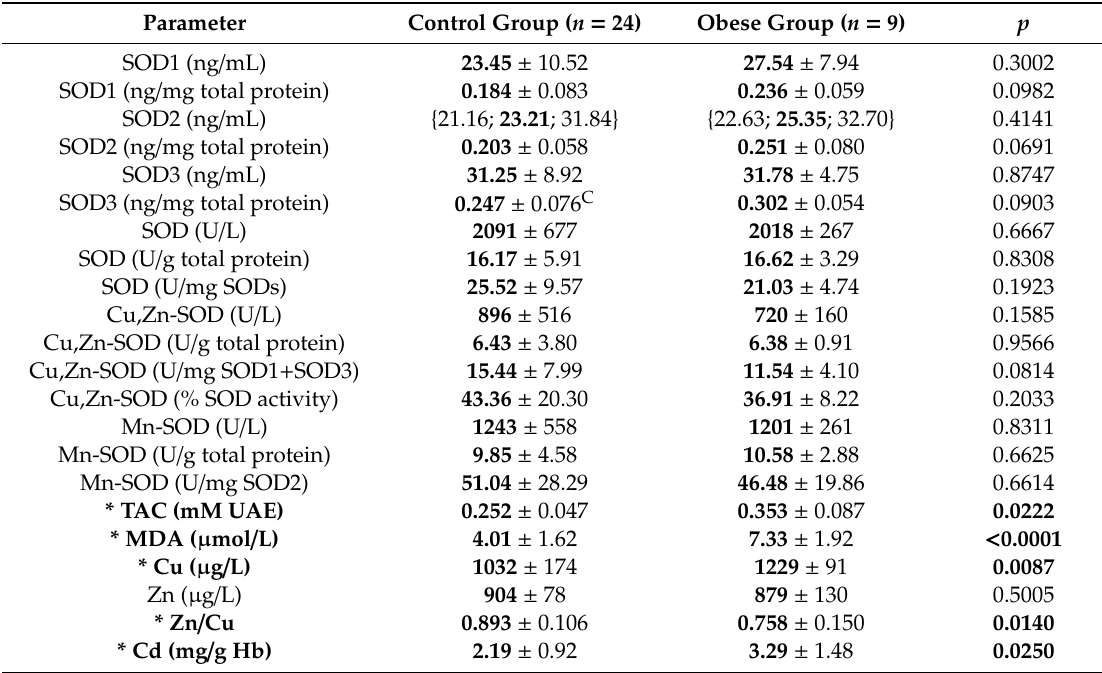
Table 2. Values of selected pro- and antioxidative parameters, and concentration of selected metals, in context of obesity, in women not exposed to cigarette